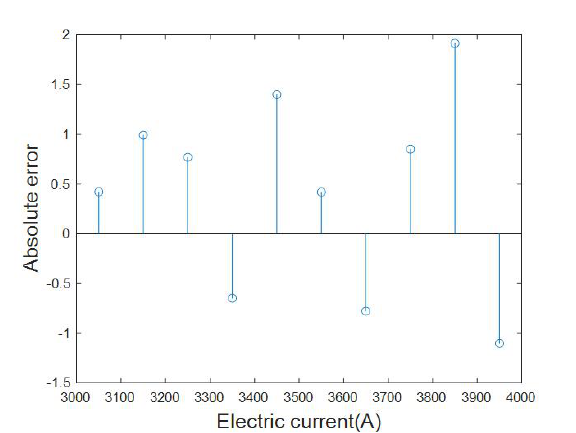
Fig. 14. Prediction absolute error of random forest regression model